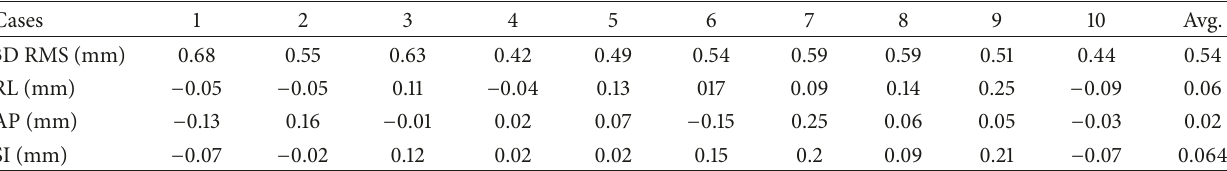
Table 2: The root-mean-square error of fiducial registration with regard to the 3D average distance and the average displacement of landmark feature points in the following three directions after DIR in the 10 cases: right-left (RL), anterior-posterior (AP), and superior-inferior